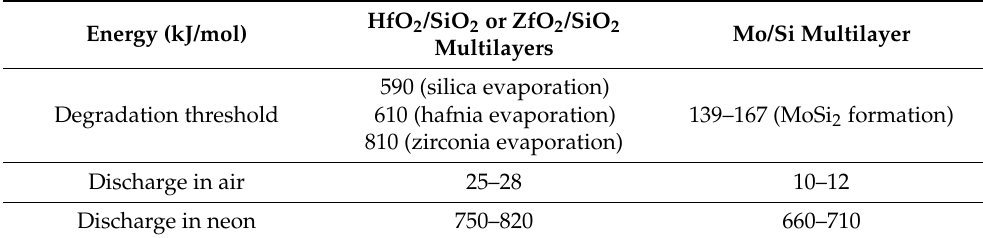
Table 5. Values of degradation thresholds and absorbed in coatings energies for discharges in air and neon. HfO 2 /SiO 2 or ZfO 2 /SiO 2 Energy (kJ/mol)